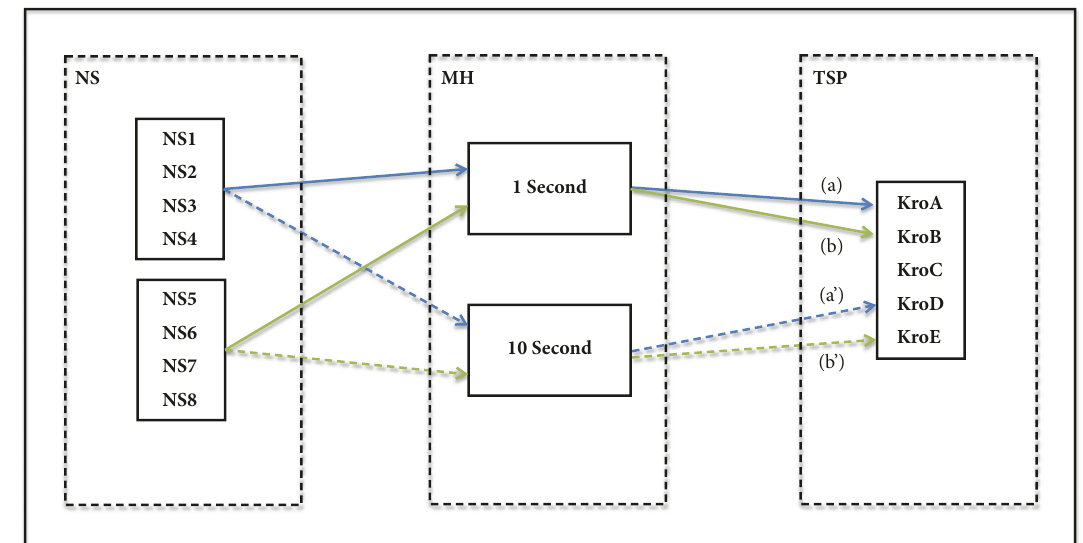
Figure 3: Proposed